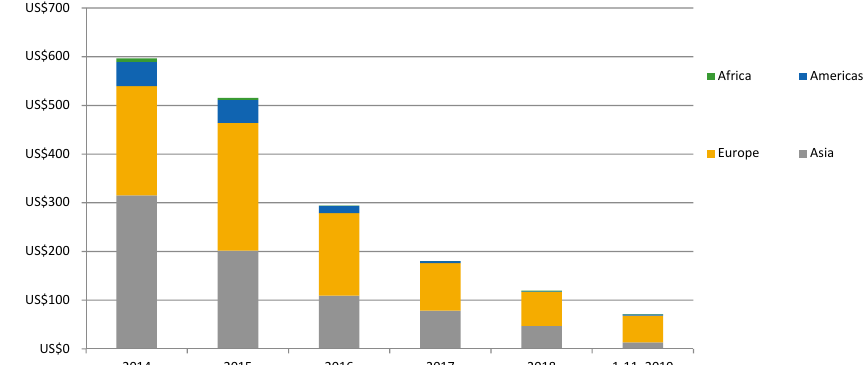
Figure 4. Taiwanese export of c-Si cells 2014–2019 (TAITRA).